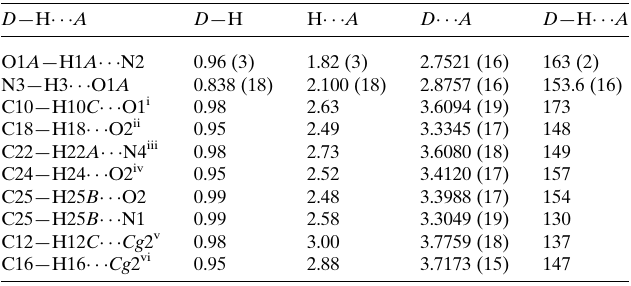
Table 1 Hydrogen-bond geometry (A˚ , (cid:3) ). Cg 2 represents the centroid of the C17–C20/N3 ring.